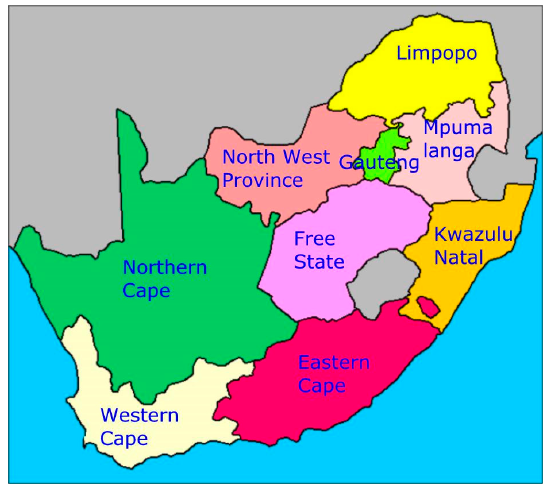
Figure 1. Map of South Africa showing the Eastern Cape province.